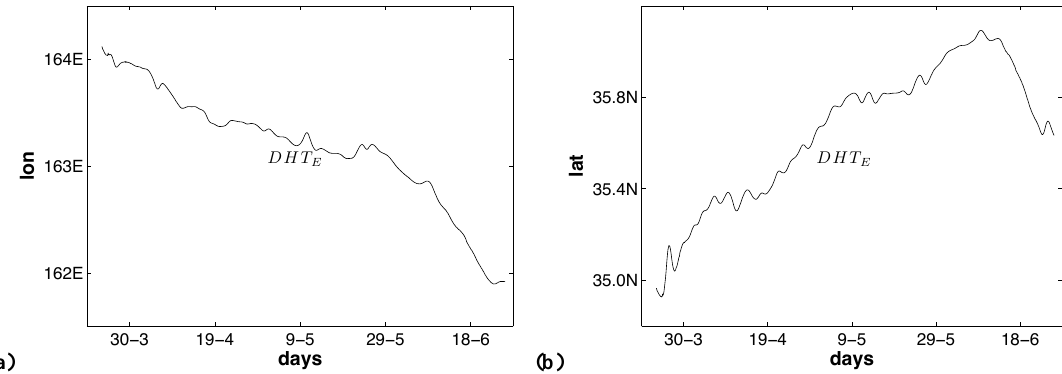
; (a) longitude vs. time; and (b) latitude vs. time. W